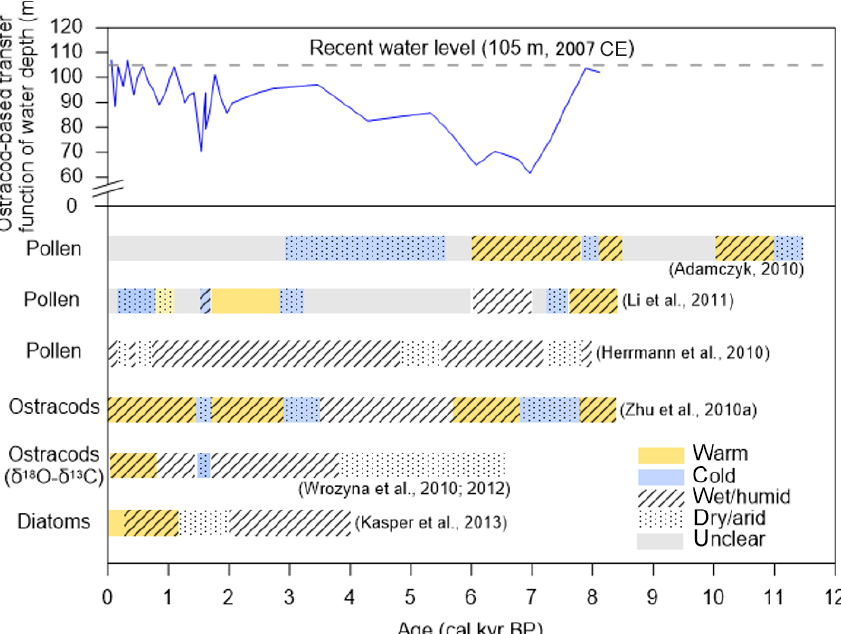
Figure 5. Comparisons of the reconstructed climate conditions based on fossils of pollen (Li et al., 2011; Adamczyk, 2010; Herrmann et al., 2010), ostracods (Zhu et al., 2010a), Ostracod δ 18 O (Wrozyna et al., 2010, 2012) and diatoms (Kasper et al., 2013) from sediment cores in, and at the shoreline of, Nam Co. Ostracod-based water depth transfer function (Zhu et al., 2010a) (blue line) was used to indicate long-term hydrological changes and all reconstructed water depth values were adjusted to the maximum water level of the lake according to the 45m difference between this study site (60m) and the deepest site (105m) at Nam Co. The main species are also shown in different